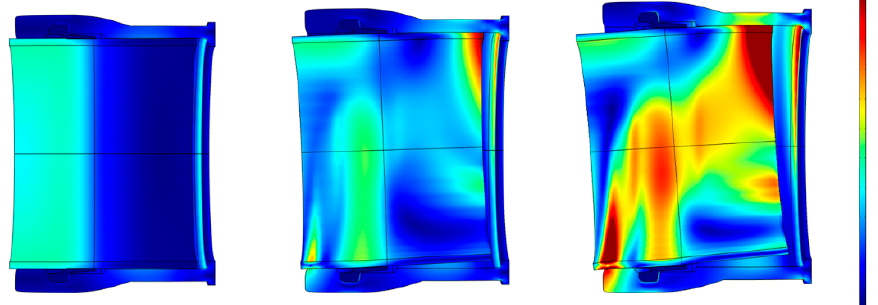
Figure 2. The distribution of the von Mises stress for increasing angular deflection. The color scale represents stresses between 0 MPa (blue) and the failure criterion of 21 MPa